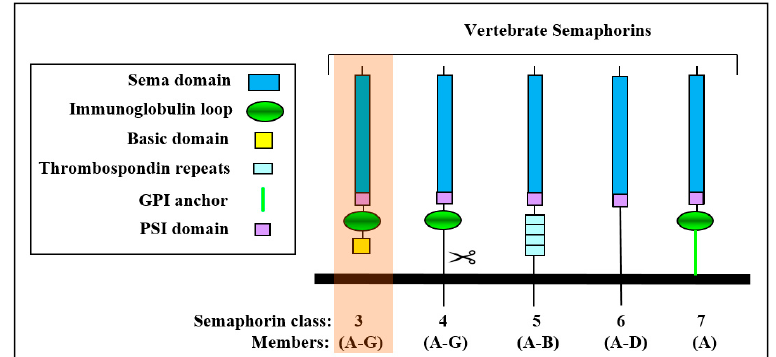
Figure 1 . The vertebrate semaphorins: Shown are the main structural features of the sub-families of the vertebrate semaphorins. The 21 members of the vertebrate semaphorin family all contain the hallmark sema domain and are divided into five subfamilies based upon structural features. The seven class-3 semaphorins are the only secreted semaphorins and are also distinguished from the other semaphorins by their basic c-terminal domain.